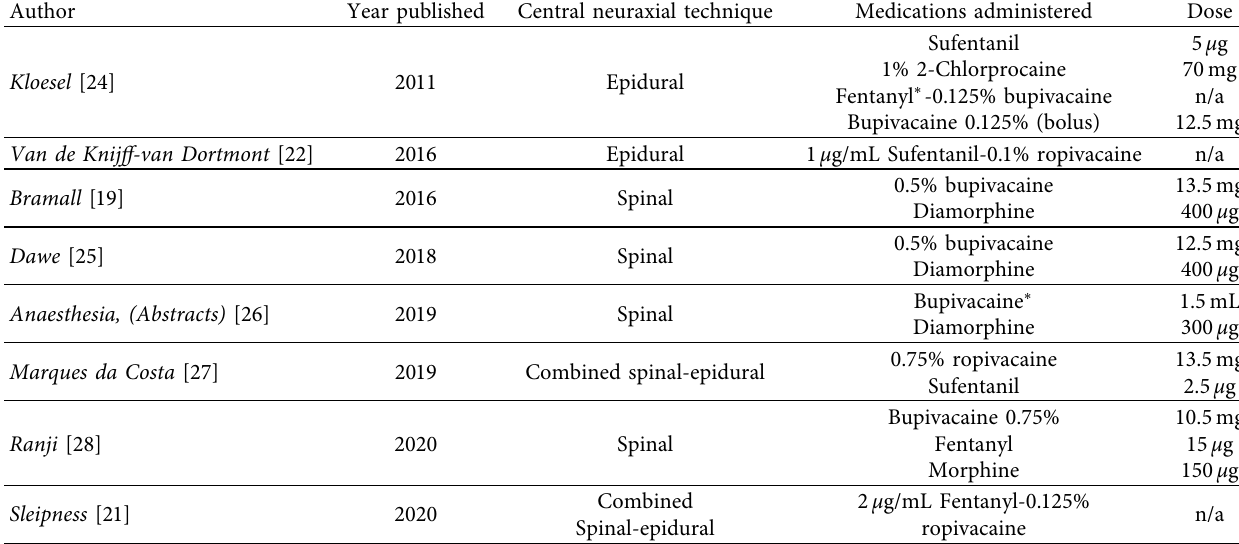
Table 1: Previous reports of central neuraxial anesthesia in parturients with Brugada syndrome, with the various medications and dosages